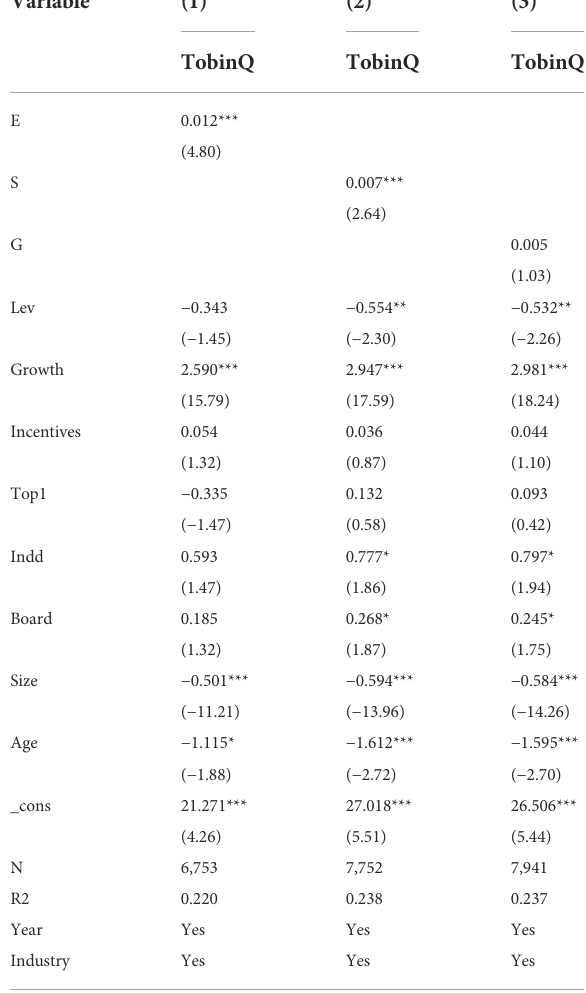
TABLE 7 Single dimension of ESG